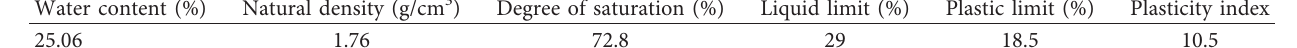
Table 1: Basic physical properties of experimental silty clay.